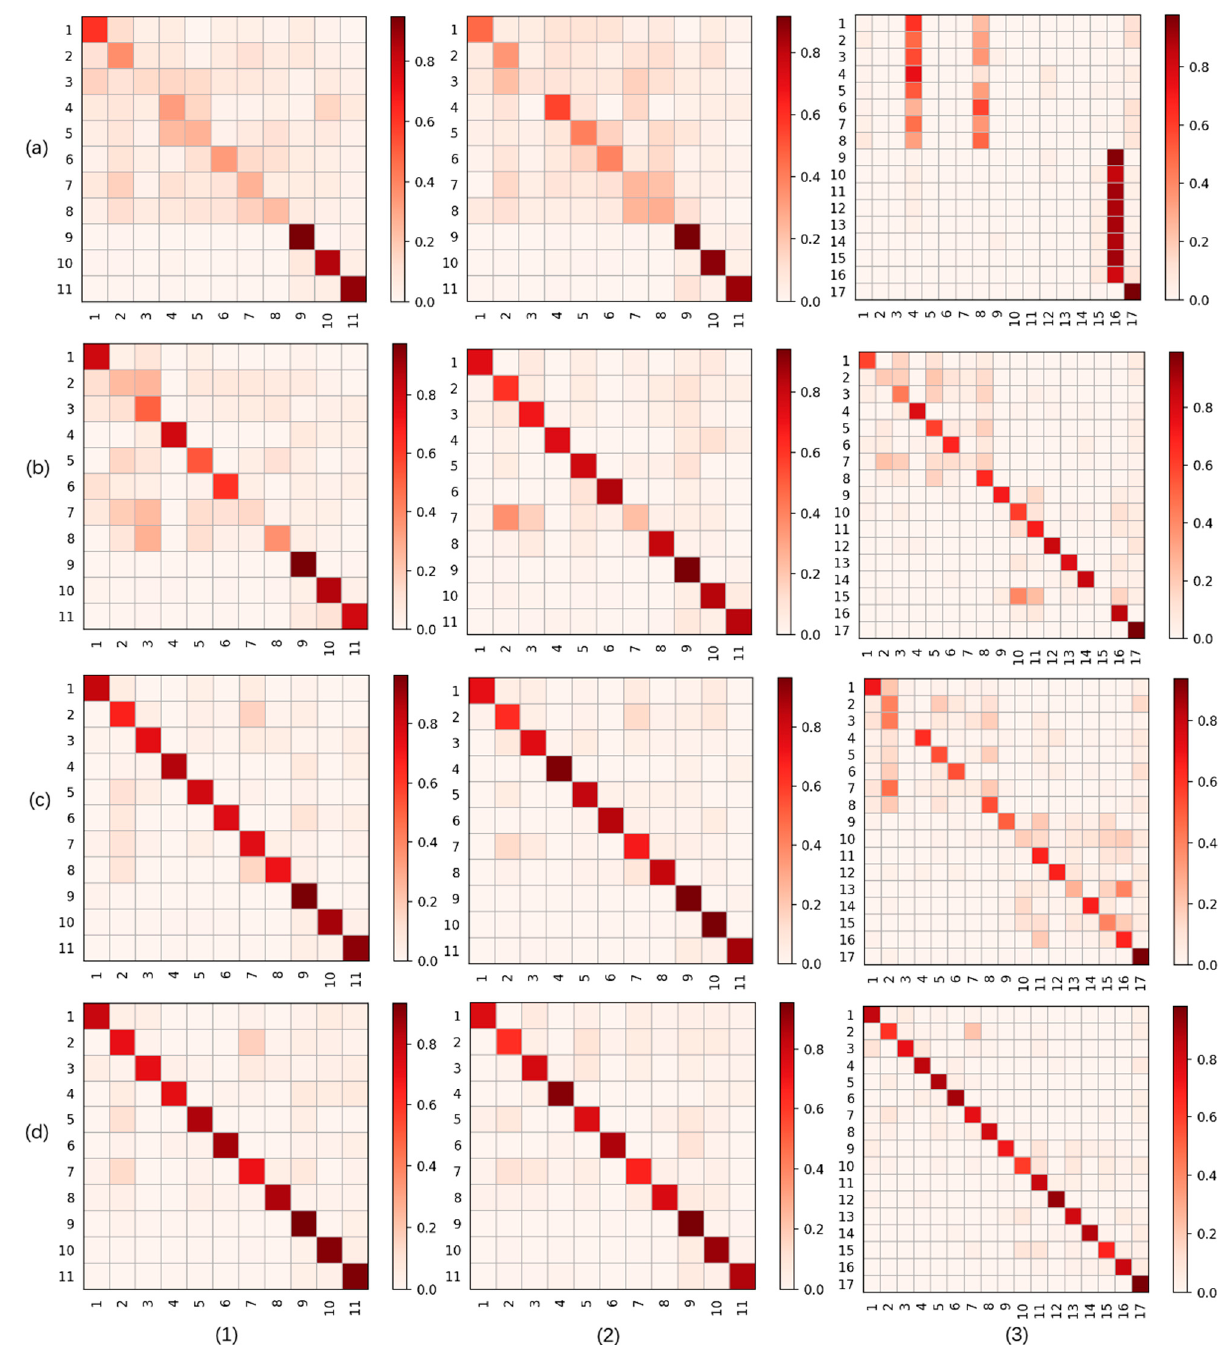
Figure 9. Confusion Matrix visualization. ( a ) VTransE+ model. ( b ) VTransE++ model (4box). ( c ) DKRL model. ( d ) CVTransE++ model. ( 1 ) The first column represents the actions of the subject. ( 2 ) The second column represents the actions of the object. ( 3 ) The third column represents the relationship. It can be seen from the figure that, with the improvement of the model, the corresponding classification performance is improved.